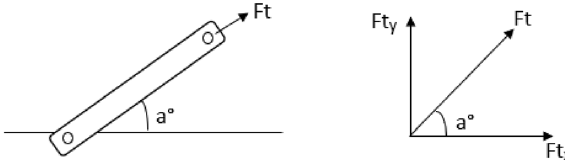
Figure 6. Diagrams showing the direction of the force in the top link.